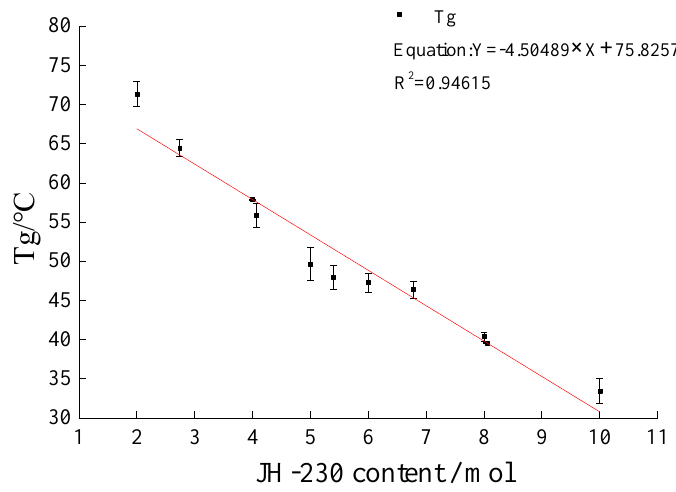
Figure 6. The second linear fitting relationship between the JH-230 content and the T g .